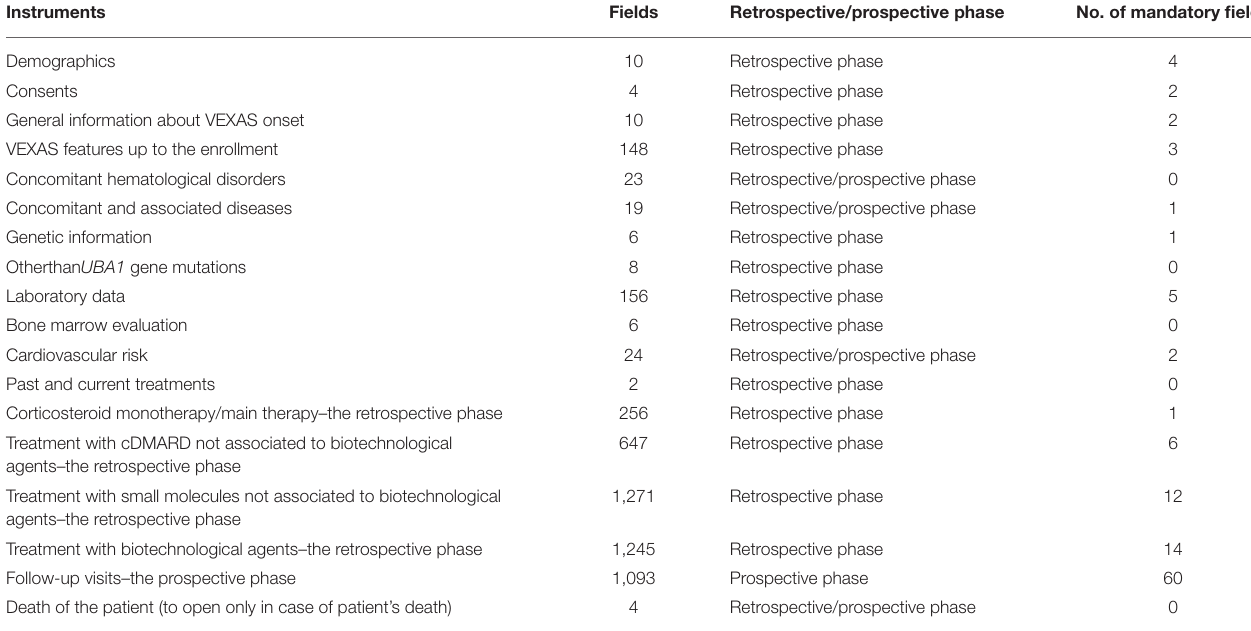
TABLE 2 | Panel of instruments constituting the registry dedicated to subject with VEXAS (vacuoles, E1 enzyme, X-linked, autoinflammatory, somatic) syndrome; the number of common data elements are also provided along with the phase (i.e., retrospective/prospective) at which they should refer.